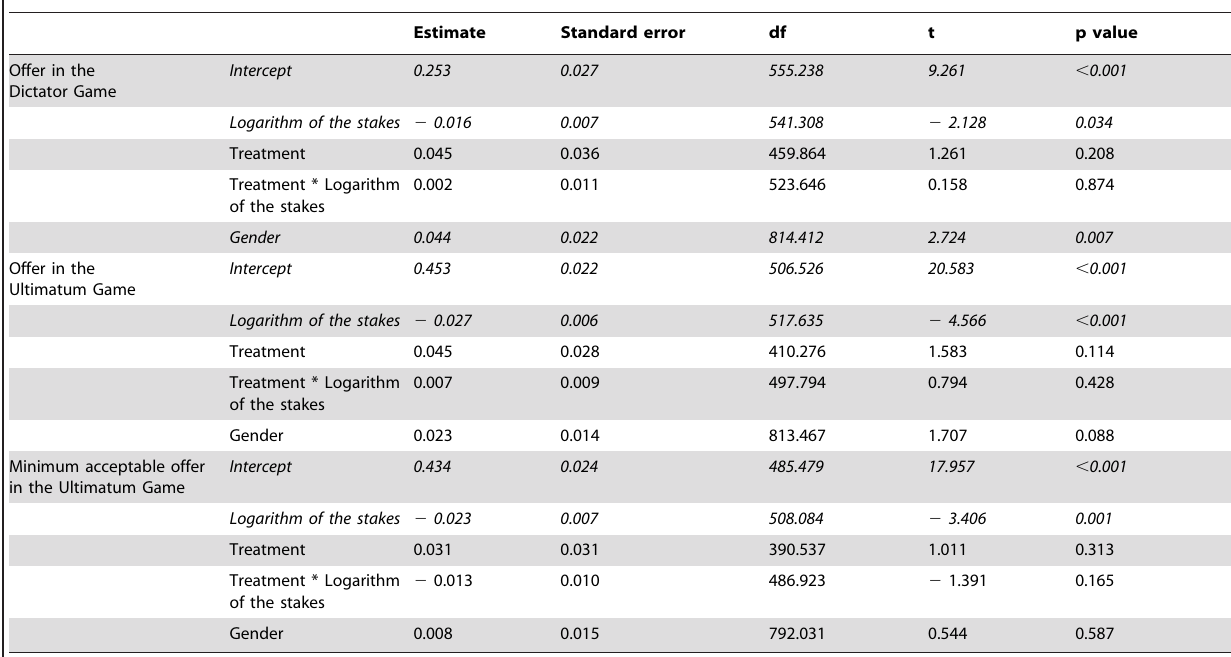
Table 2. Influence of the stakes on the